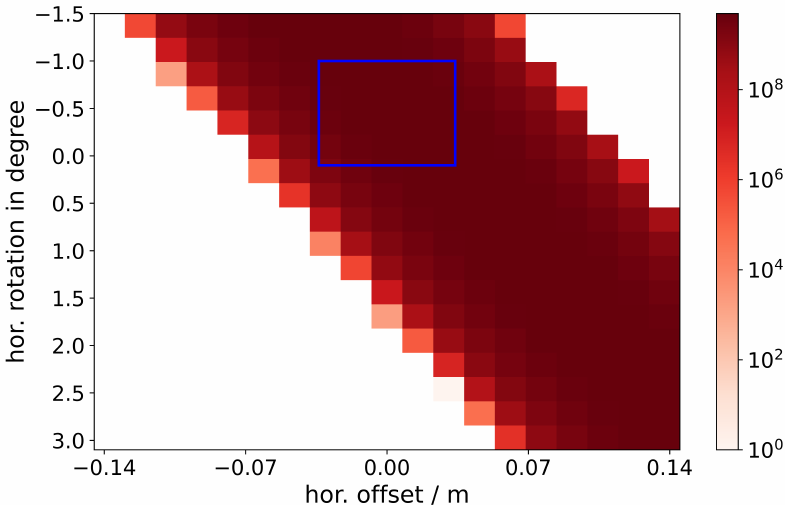
Figure 2. The intensity map for the moderator view relating horizontal offset of the extraction system along the inside of the moderator and rotation. A window for physically possible settings is outlined in blue. The ridge of highest intensity corresponds to the ratio between offset and rotation to keep looking at the location of highest flux inside the moderator. The inclination of that ridge is angle = 27.3 ×